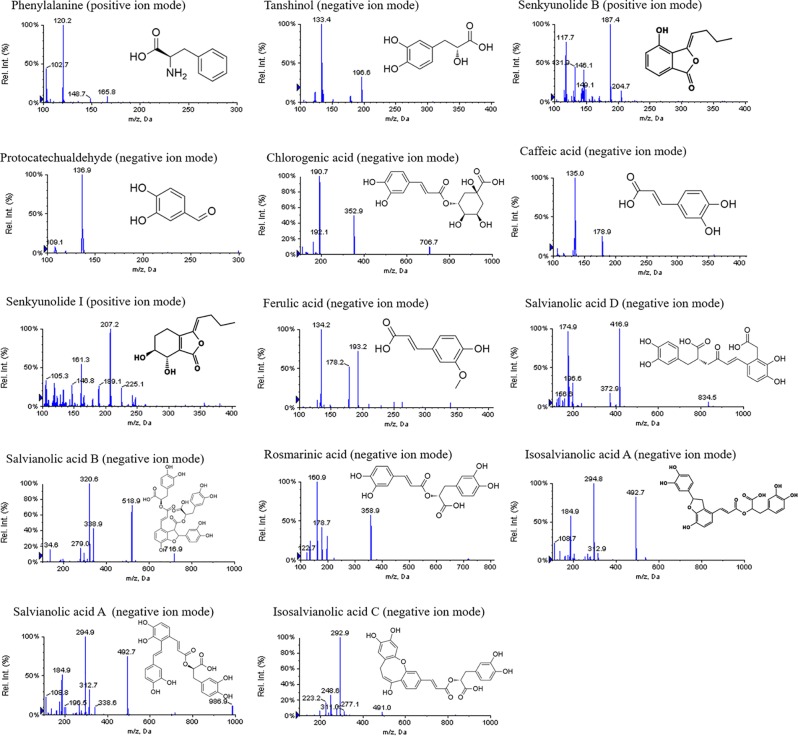
Mass spectrums and chemical structures of main compounds in GXNT.